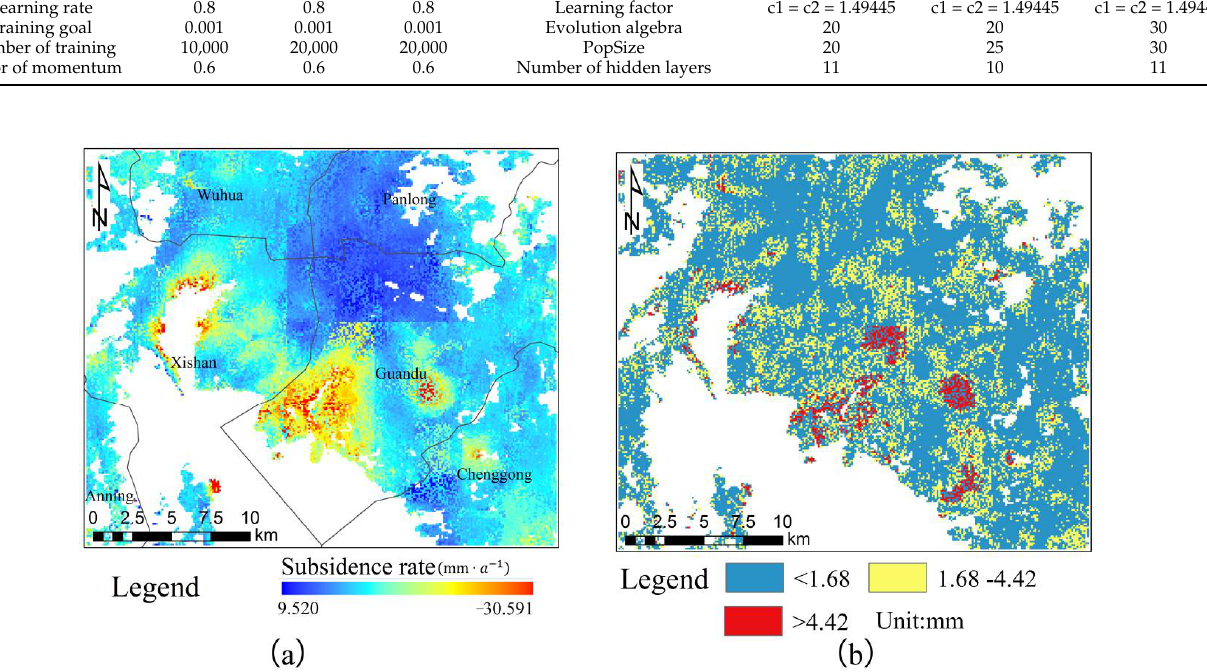
Figure 14. Prediction result and prediction error of subsidence rate in LOS direction; ( a ) is the prediction of the subsidence rate in the main urban area of Kunming from 2018 to 2021, using the constructed PSO-BP; ( b ) is the error between the predicted subsidence rate and the actual monitoring rate of InSAR.